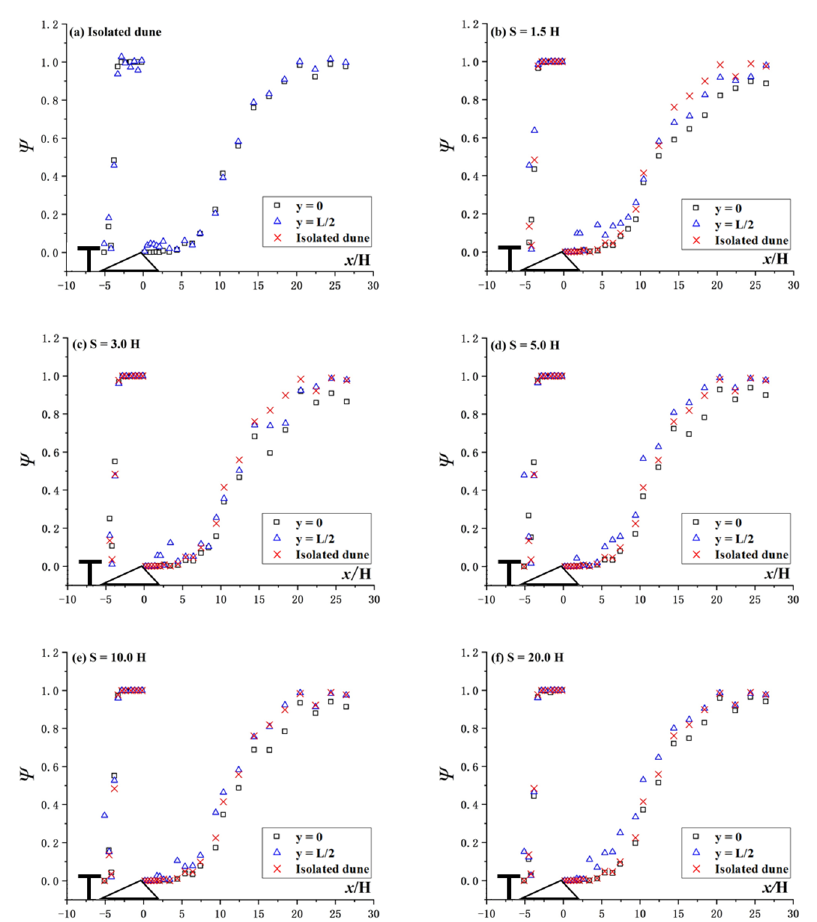
Figure 8. Fraction time threshold time parameter ψ with normalized distance x / H. H is the height of sand dune, L is the distance of piers of bridge, S is the distance between bridge and sand dune and y is the distance between measuring position and the